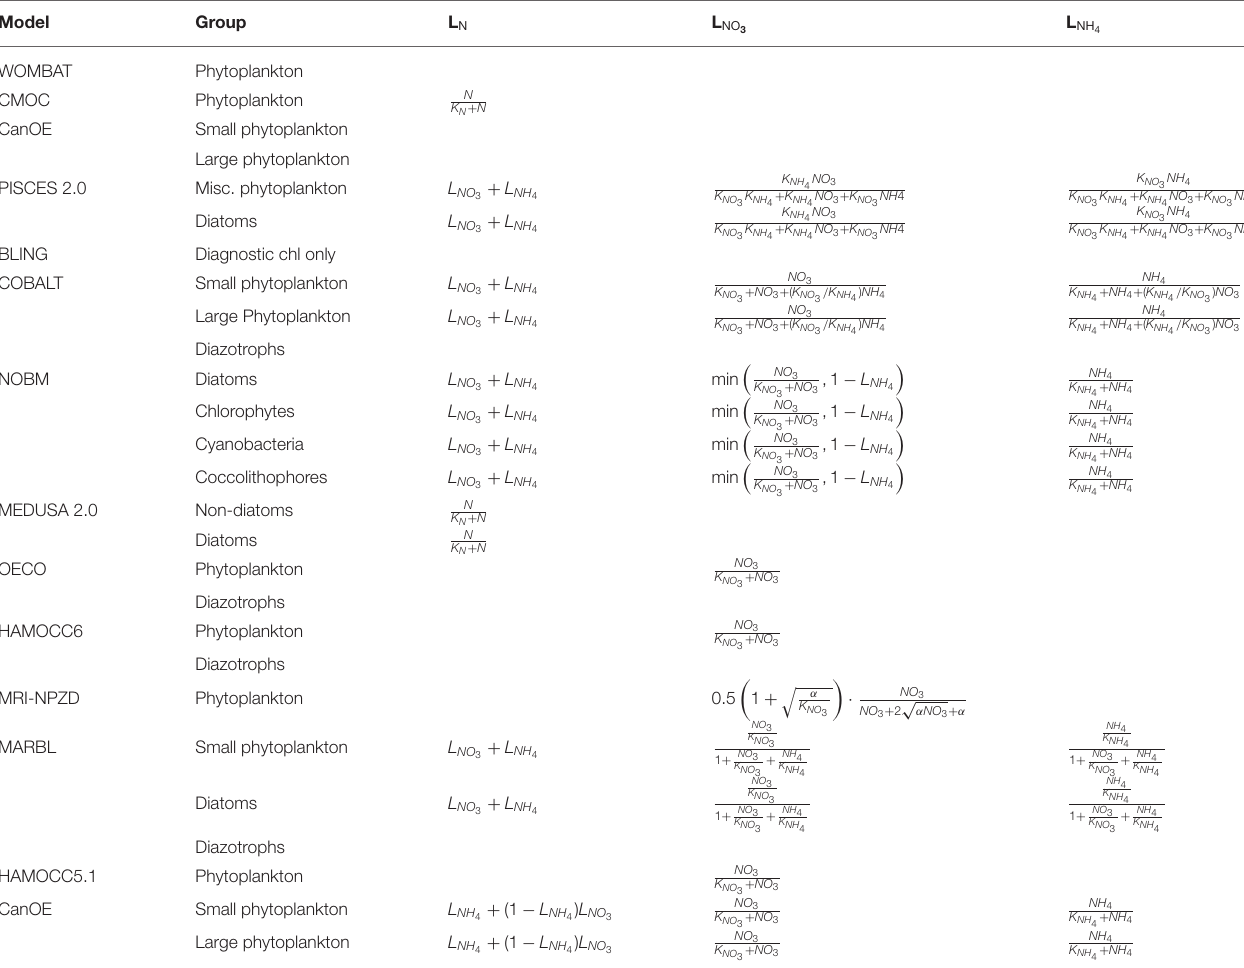
TABLE 3 | Nitrogen nutrient-limitation factors across all CMIP6 ESMs.